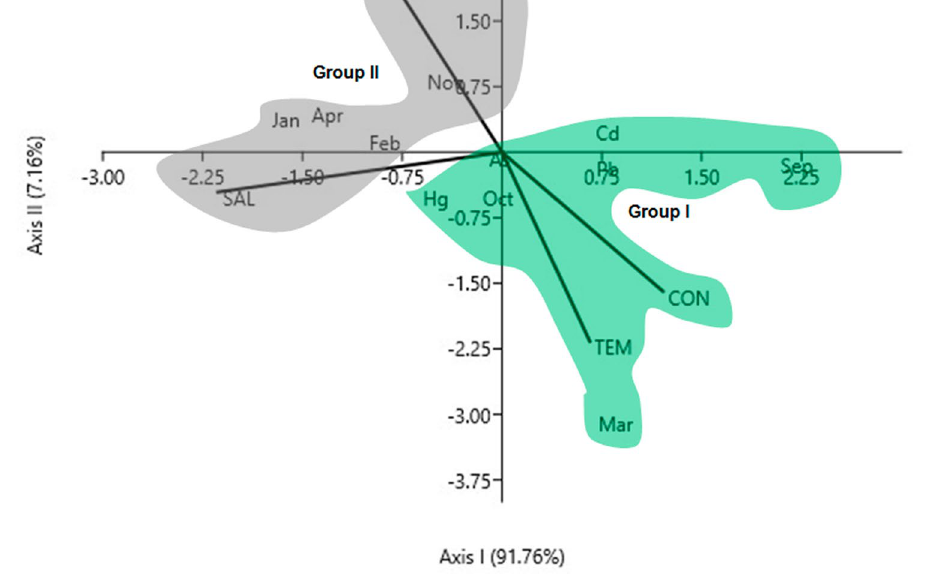
Fig. 3 Bi-chart CCA was estab- lished using four environmen- tal parameters and four heavy metals observed in fish flesh of highly commercial species in Indus River Estuary. Six clad of Euclidean distance was noticed (Fig. 5) from a cluster estab-